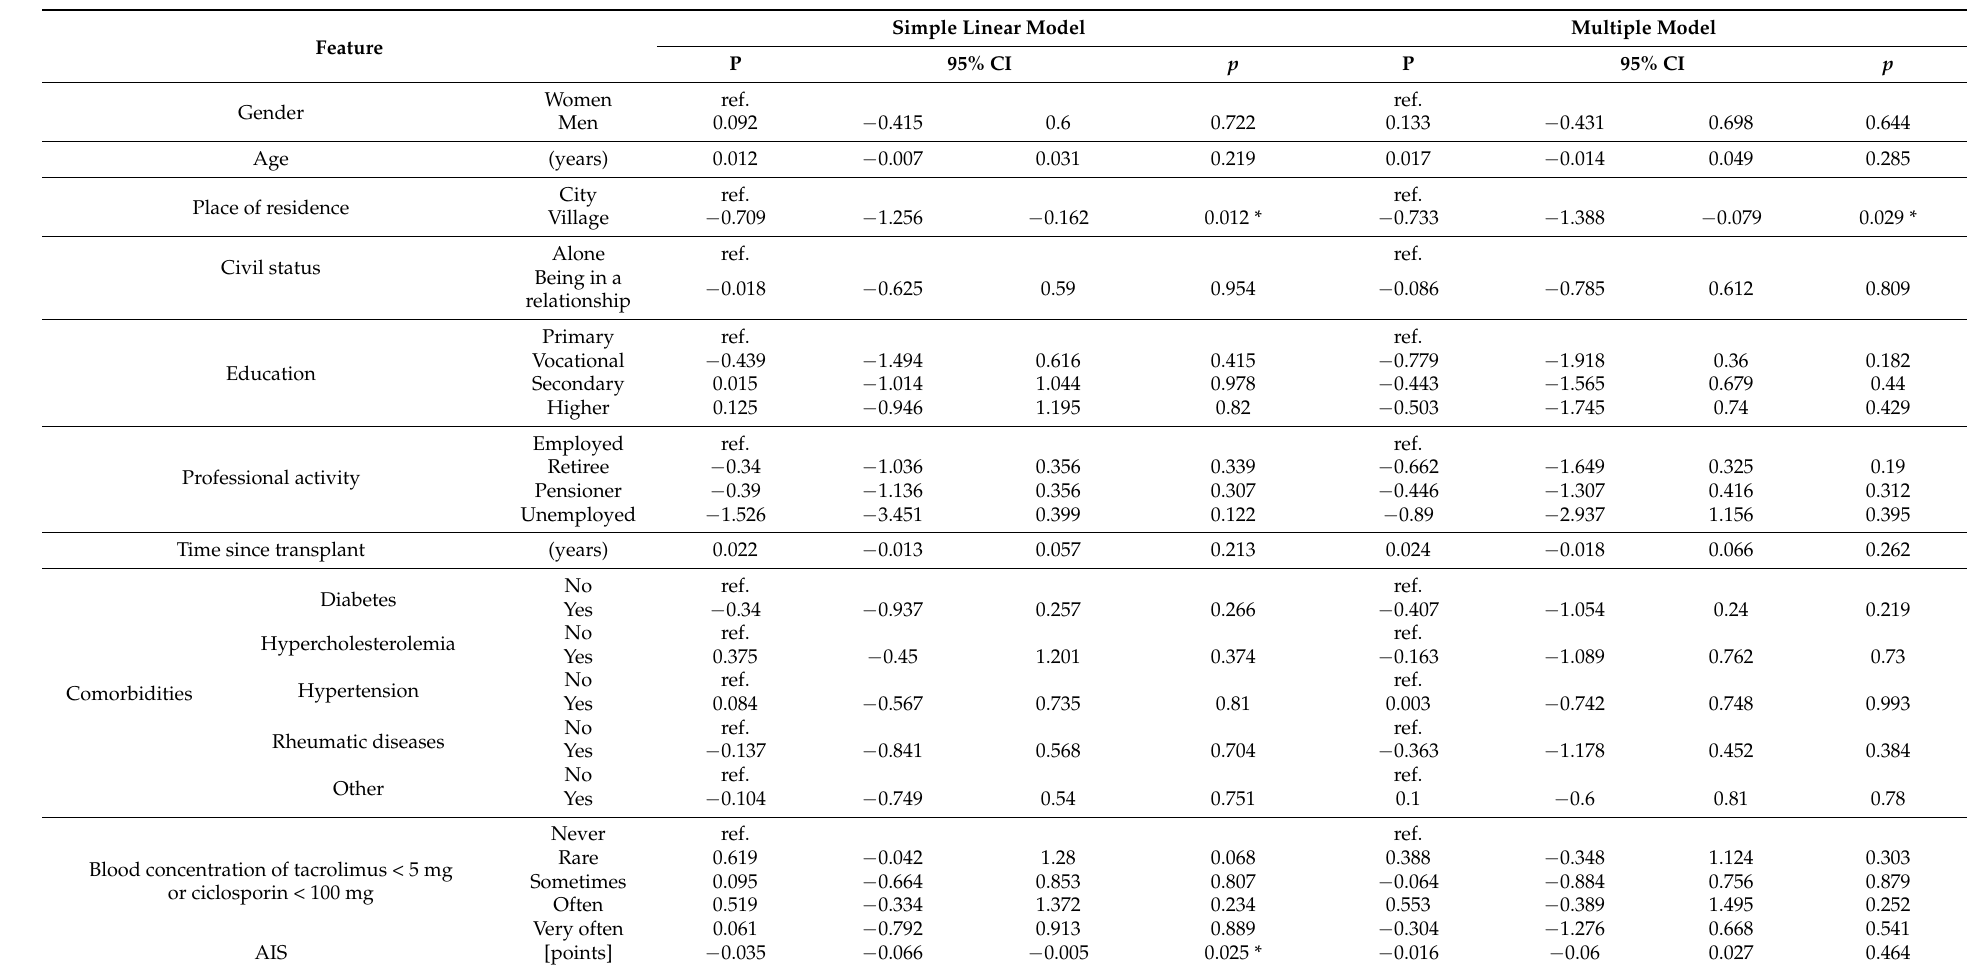
Table 3. ARMS overall adherence: simple linear regression and multiple regression